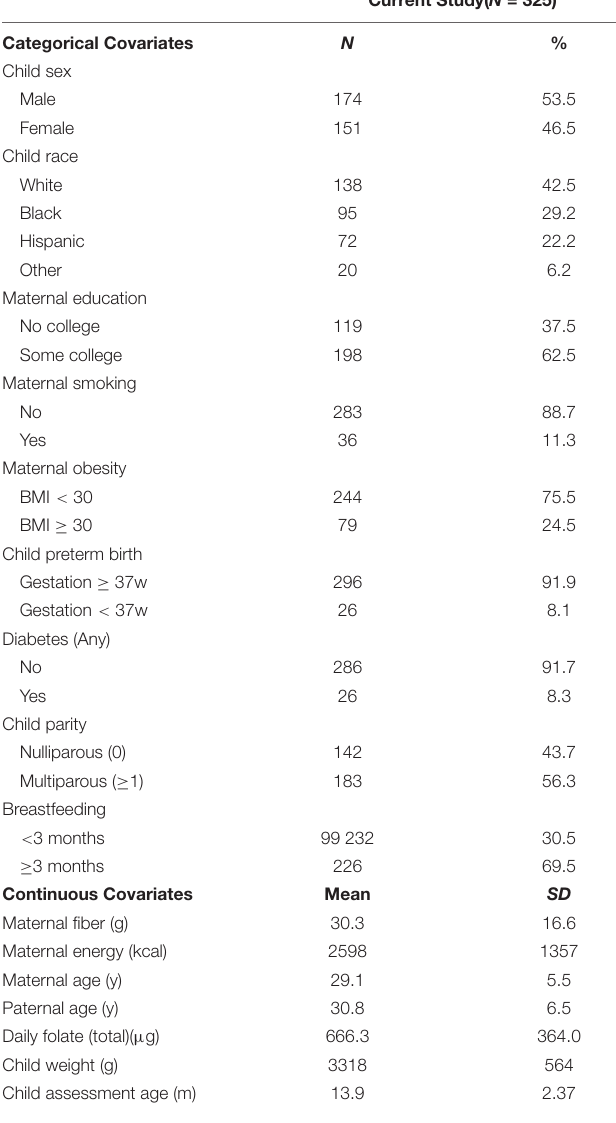
Figure 1 . With the exception of social relatedness index and the Competency subscales ( compliance, attention, mastery, imitation, empathy, and prosocial ), lower scores indicate favorable behavior